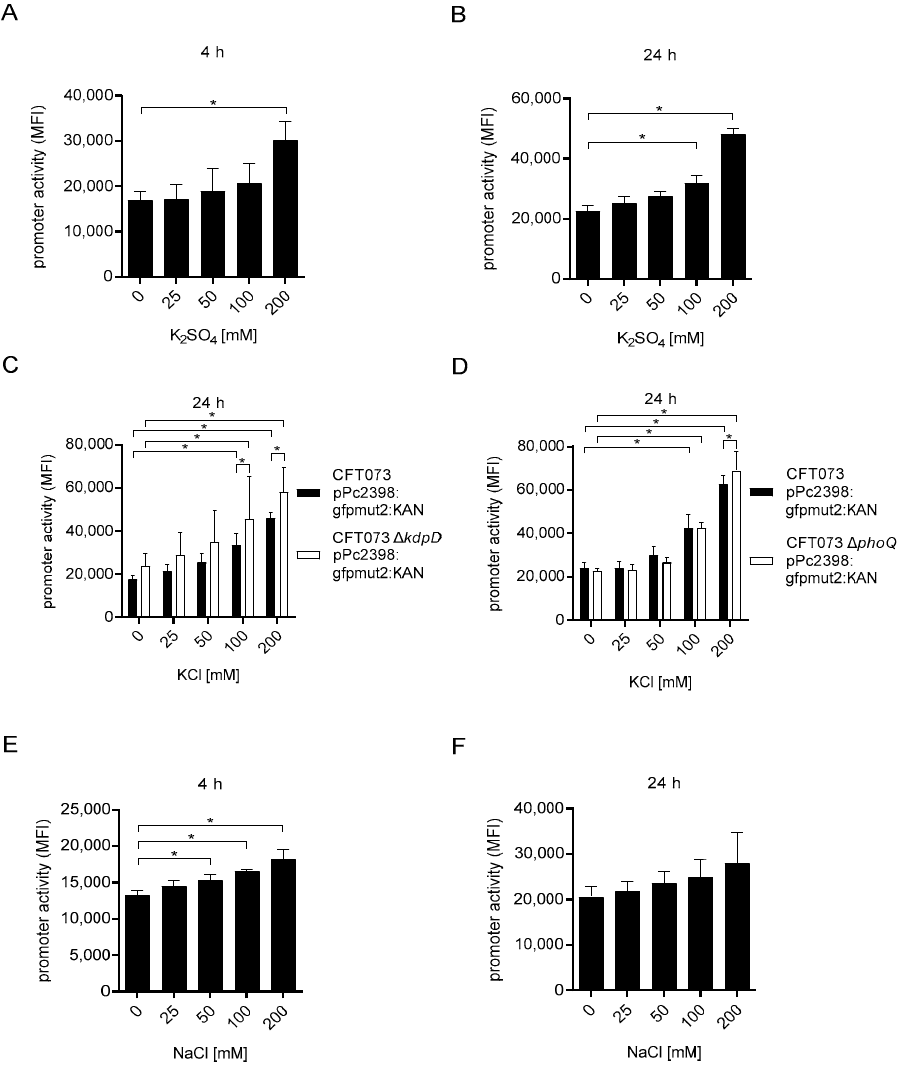
Figure 6. Potassium and sodium induce P2. We cultured CFT073 pPc2398:gfpmut:KAN (overnight culture diluted 1:6) in M9-minimal medium in the absence or presence of increasing amounts of potassium sulfate as indicated for 4 ( A ) or 24 h ( B ). To test a possible involvement of the two-com- ponent systems KdpD/E ( C ) and PhoQ/P ( D ) in potassium detection, we cultured the corresponding gene-deficient strains CFT073 Δ kdpD pPc2398:gfpmut:KAN and CFT073 Δ phoQ pPc2398:gfpmut:KAN in the absence or presence of increasing amounts of potassium chloride